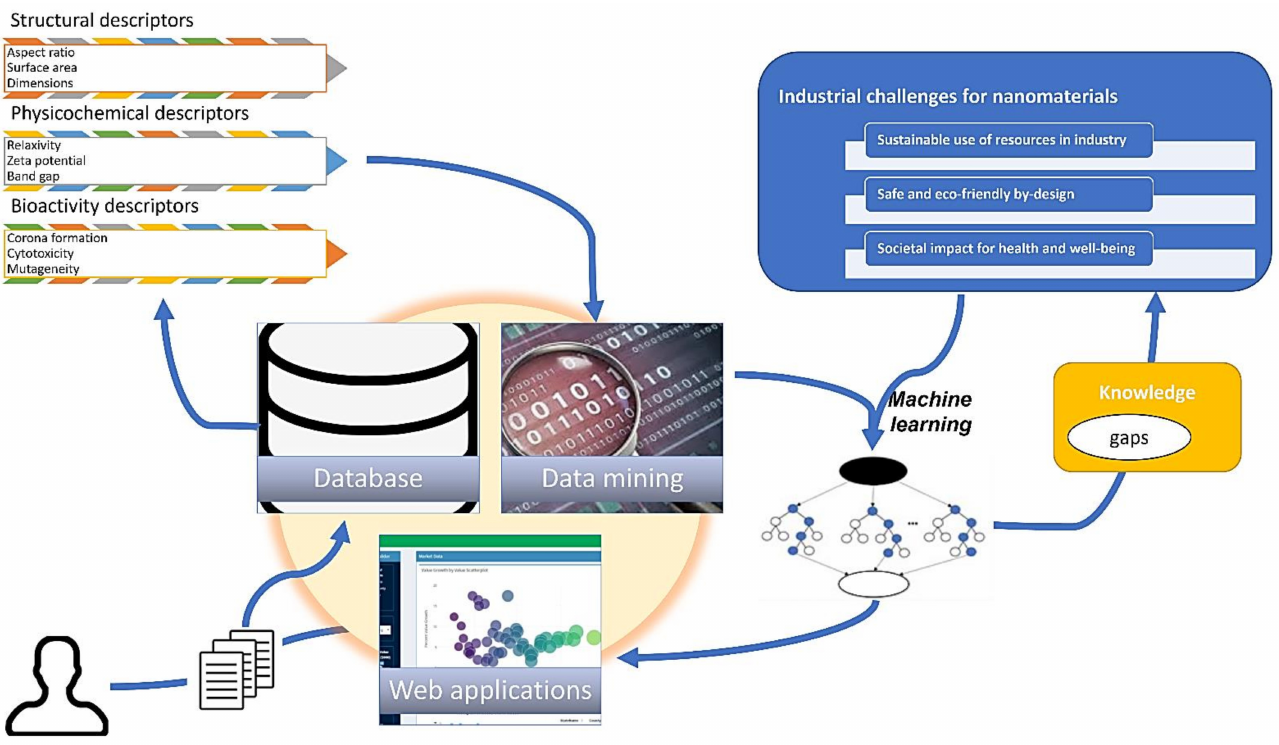
Figure 5. Database and knowledge discovery workflows to support innovation and circularity in